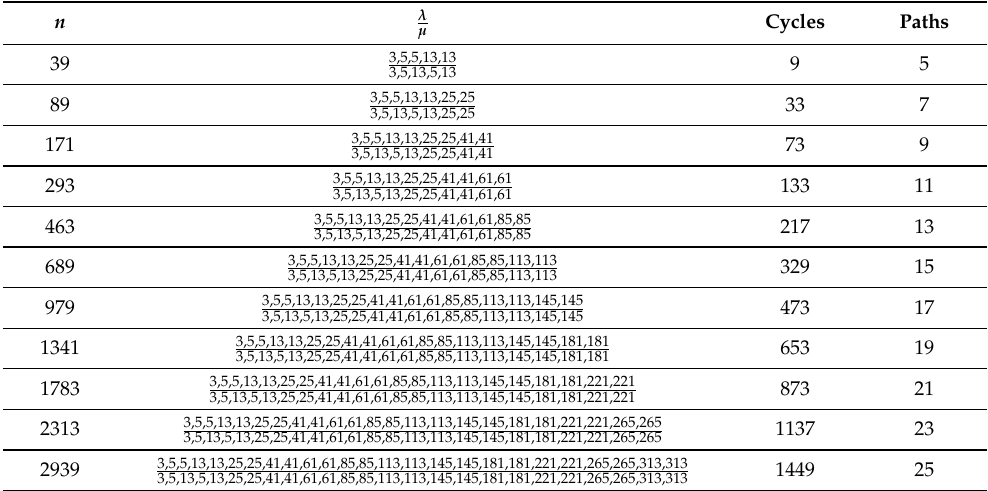
Table A2. Number of cycles and paths in the meander induced by compositions of type O of n